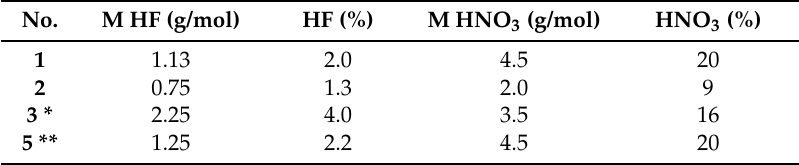
Table 3. Composition and concertation of the hydrofluoric and nitric acids baths for scaffolds polishing. No. M HF (g/mol) HF (%) M HNO 3 (g/mol) HNO 3